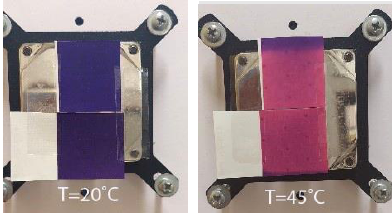
Figure 2. Visual presentation of thermochromic prints obtained on different paper substrates of body-heat activated PP-31 ink under (20 ◦ C) and above (45 ◦ C) ink’s T A .